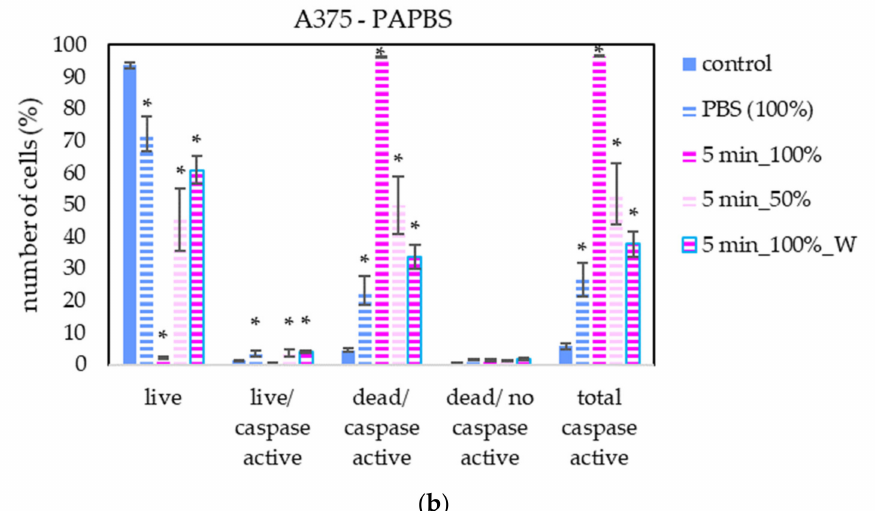
Figure 11. The effect of PAL on caspases 3/7 activity in human melanoma cells A375, measured 24 h after PAL application. Plasma-activated medium—PAM ( a ) or plasma-activated PBS—PAPBS ( b ) activated for 5 min in 100% or 50% concentration were used. Time of PAL action was 24 h or 30 min, after which PAL were replaced with untreated medium (“washing”, W, blue frames). The significant results ( p < 0.05) are marked with *. Significance of 100% PAPBS was tested compared to cells in 100% PBS, significance of the other samples was tested compared to control.